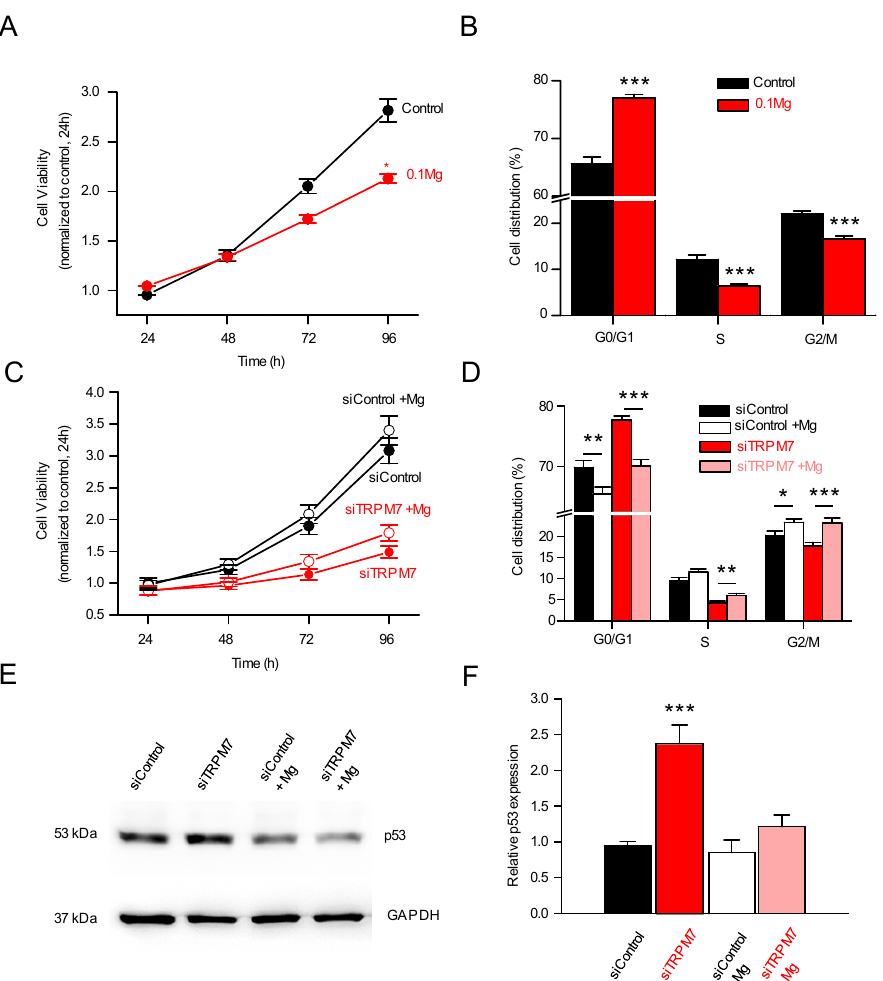
Figure 6. Expression of p53 is magnesium-dependent. ( A ) Cell viability was assessed with usual magnesium concentration (Control) or with reduced magnesium concentration (0.1 mM, n = 3). * indicates p < 0.05 (2-ways ANOVA). ( B ) When magnesium concentration was reduced (0.1 mM), PS-1 cells accumulated in G0/G1 phase, with a decreased percentage of cells in S and in G2/M phases ( n = 3). *** indicates p < 0.001 (2-ways ANOVA). ( C ) Effect of Mg 2+ supplementation, with or without TRPM7 silencing, on cell viability ( n = 3). ( D ) Mg 2+ supplementation reversed the effect of TRPM7 silencing on cell cycle regulation ( n = 3). * indicates p < 0.05; ** indicates p < 0.01; *** indicates p < 0.001 (2-ways ANOVA) ( E ) Western blot showing protein expression of p53 in PS-1 cells. Expressions are shown in different conditions: either transfected with siControl or siTRPM7, or in combination with increased magnesium concentrations (72 h post transfection). ( F ) Quantifications of relative p53 expression in PS-1 cells: magnesium supplementation was able to restore the effect of TRPM7 silencing on p53 expression ( n = 4). *** indicates p <